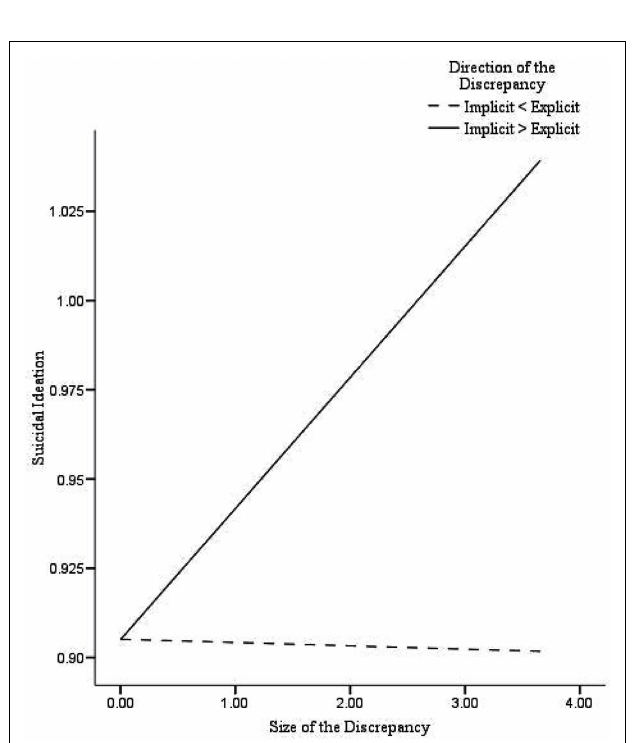
FIGURE 2 | Predicted values for suicidal ideation, illustrating the interaction between the size of the discrepancy and the direction of the discrepancy.